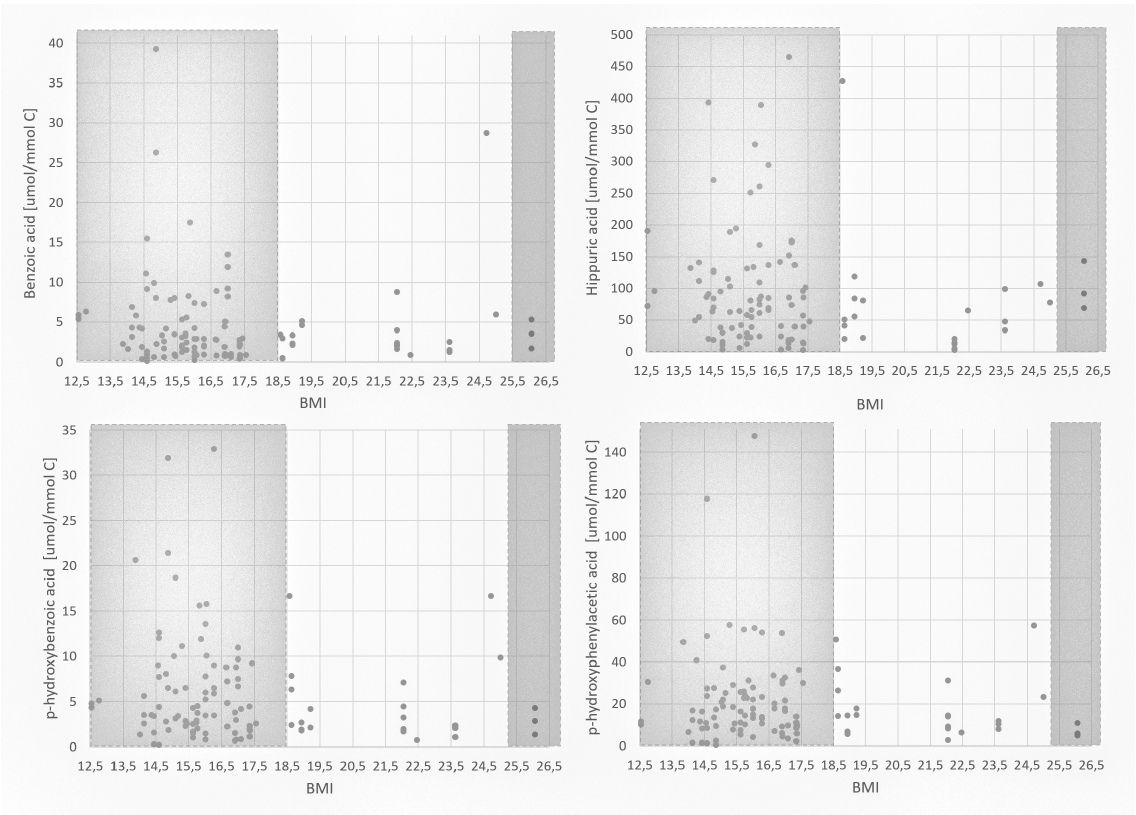
Figure 1 Relationship between BMI values and the concentrations of the analyzed carboxylic